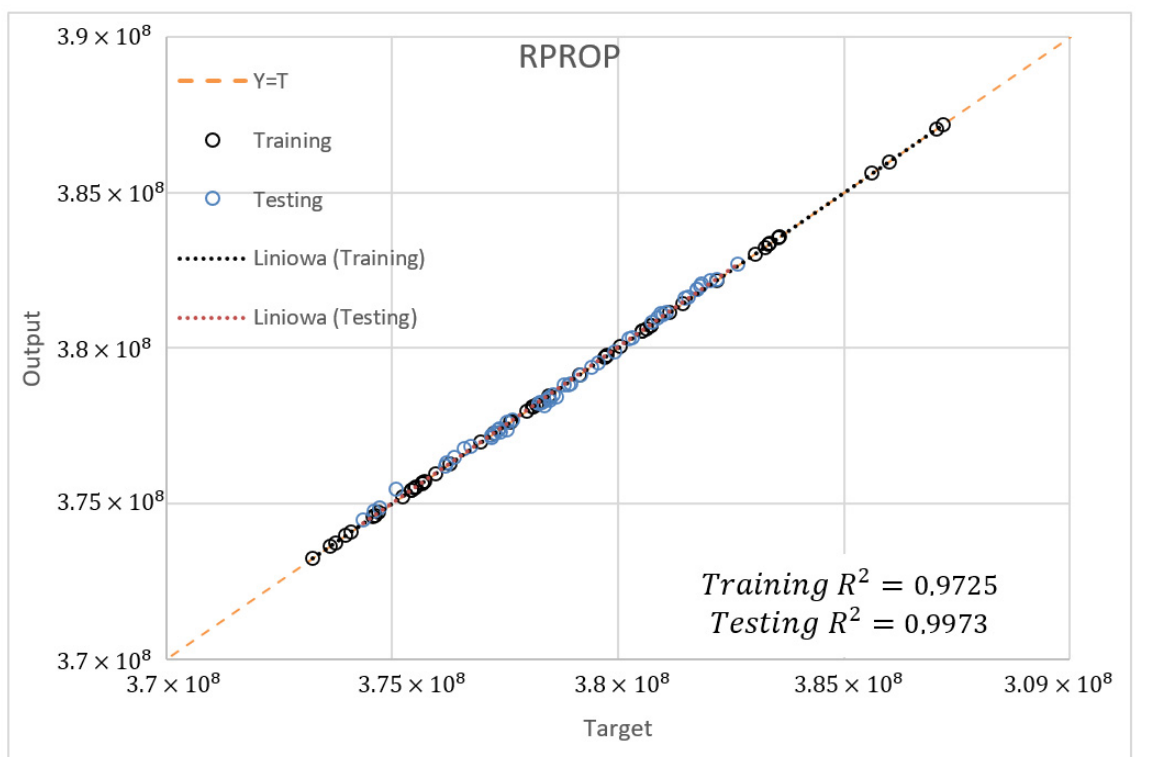
Figure 24. Comparison of data matching used for training and validation for the RPROP algorithm (NN 20-3-1).